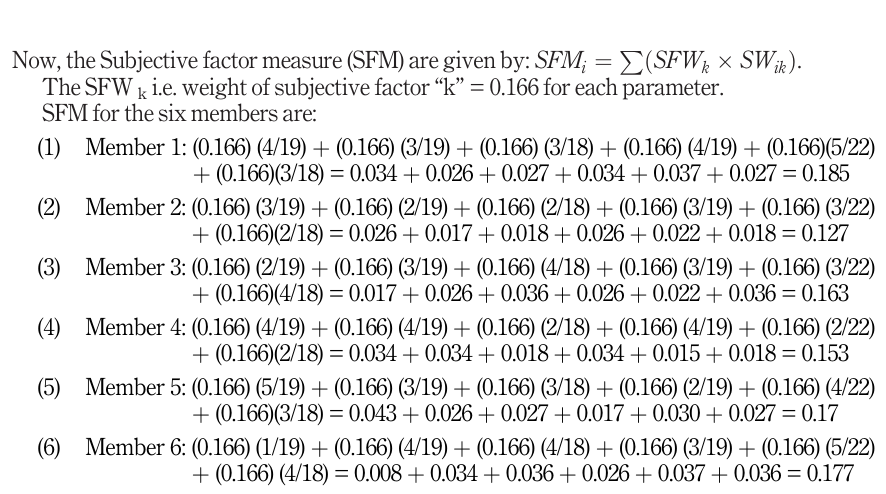
Theperformancemeasurefordifferentmembers: Performance Measure PM